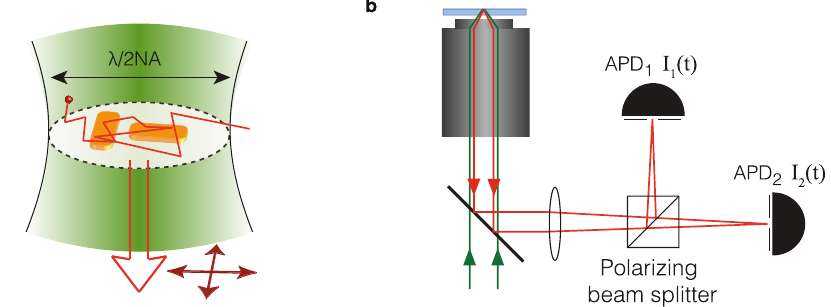
Figure 1. We propose a nano-antenna version of dual focus FCS based on polarization encoding the fluorophore position near plasmonic nano-antennas. ( a ) Two plasmon antennas with an orthogonally polarized resonance are placed in the diffraction-limited focus of a fluorescence confocal microscope. When diffusing fluorophores are near an antenna, the otherwise unpolarized fluorescence becomes polarized along the antenna resonance. ( b ) Fluctuating intensities on two APDs that are confocal with both antennas, but sensitive to orthogonal polarizations, will show a temporal cross-correlation. The antenna spacing acts as a ruler for measuring diffusion